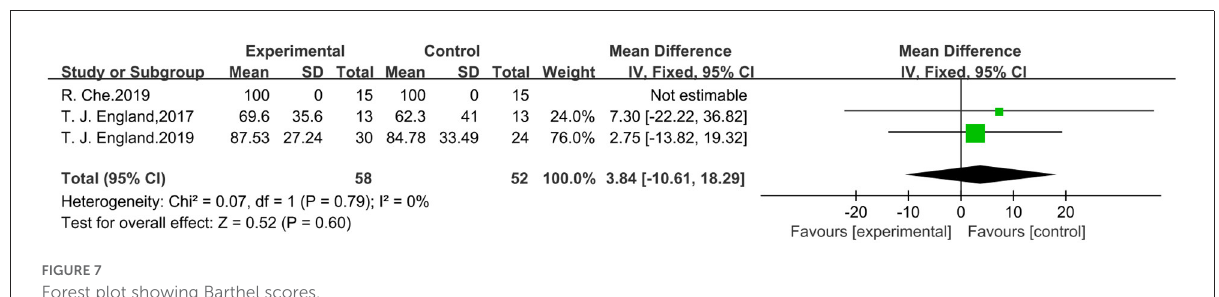
FIGURE7 Forest plot showing Barthel